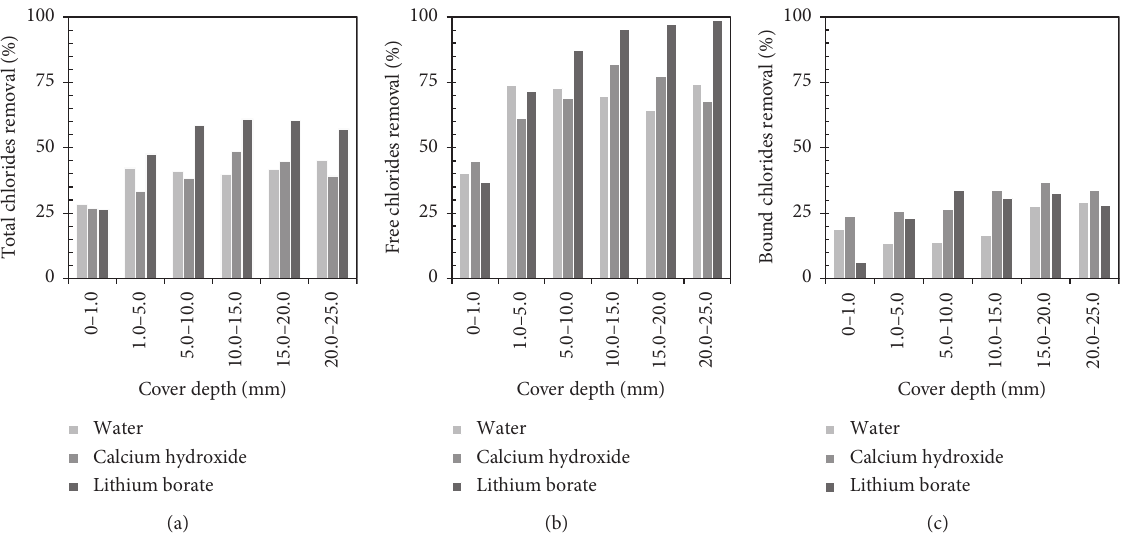
Figure 7: Direct comparison on the efficiency on chloride removal for each designated cover depth in terms of (a) total, (b) free, and (c) bound